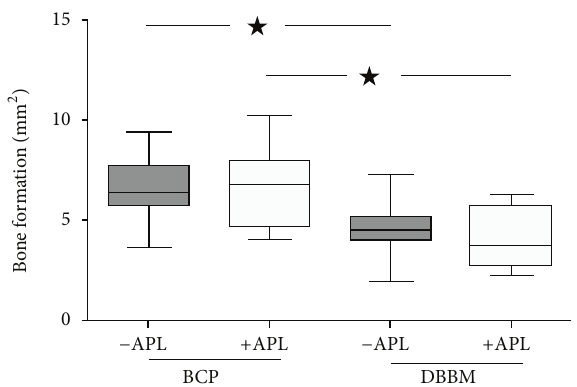
Figure 4: Box plot showing bone formation area in the defect at 6 weeks after implantation. In the defects filled with BCP, the newly formed bone area was significantly higher than that observed in the defects filled with DBBM ( ∗ P < 0.001). No significant differences were observed between defects filled with BCP and BCP+APL, as well as between defects filled with DBBM and